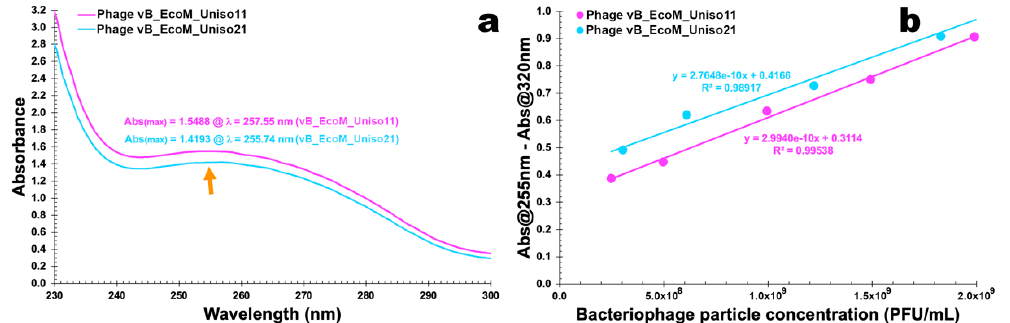
Figure 8. UV-Vis spectral scans of dilutions of the concentrated phage suspensions ( a ) and linear relationships between the concentration of (whole) phage particles and absorption at 255 nm corrected for cell debris and other cytoplasmatic proteins at a wavelength of 320 nm ( b ).